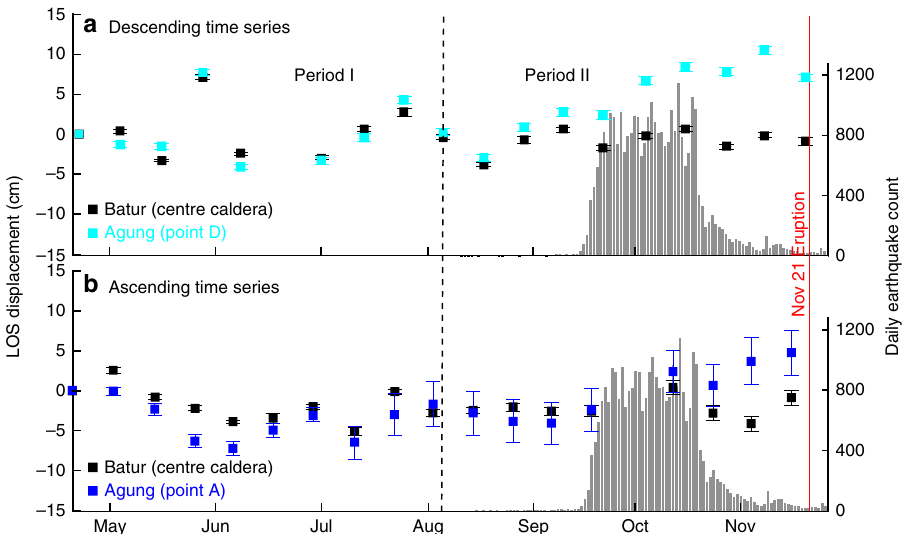
Fig. 4 Time series of ground deformation at Agung and Batur volcanoes. The time series at Agung are plotted at the location of the maximum cumulative los displacements for a descending (light blue) and b ascending data set (dark blue), (see points D and A in Fig. 3c, d). The time series of the centre of Batur (black) is shown as a reference as it is not deforming during the time period. The central value and the uncertainty (1 σ ) at each epoch correspond to the mean and the standard deviation of line-of-sight displacements calculated for a 21 × 21 window